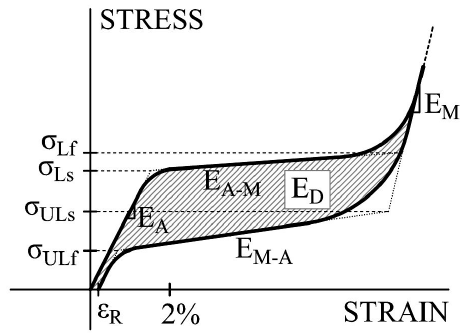
Figure 2. Idealized cyclic behavior of superelastic shape memory alloy (SMA).